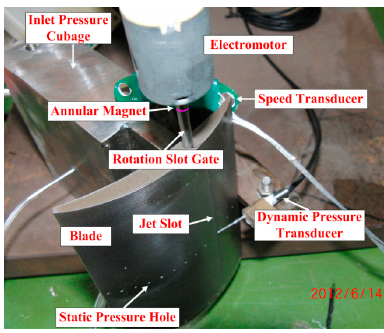
Figure 4. Measurement system of pulsed jet.